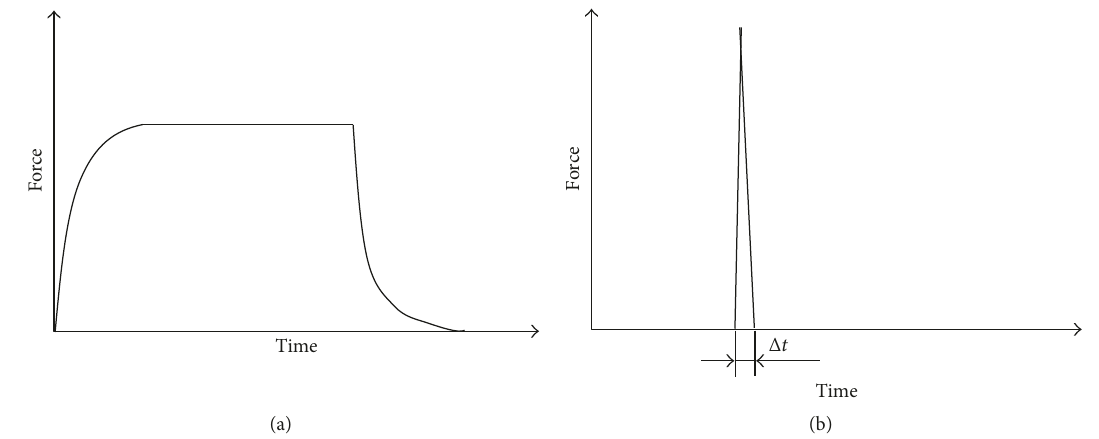
Figure 2: Generated force profiles: (a) general force, (b) impulse